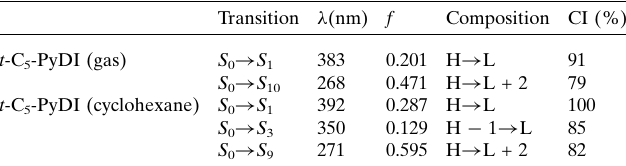
Table 5 Electronic excitation energies ( (cid:4) ), oscillator strengths ( f ), corresponding compositions and the configuration interactions (CI) for t -C 5 -PyDI in gas and in